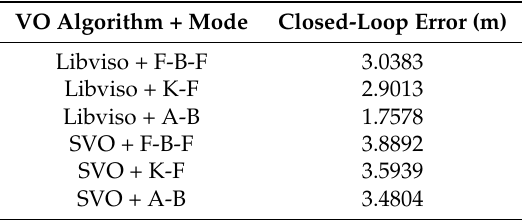
Table 4. Experiment 1: The closed-loop error on dataset1.